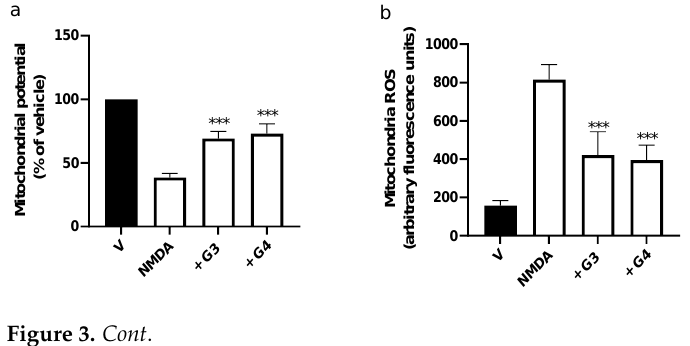
Figure 3. Effect of G3 and G4 phosphorous dendrimers on NMDA-induced changes in Ψm and ROS levels. Neurons were treated with vehicle (V), G3, or G4 phosphorous dendrimers (10 µM) for 1 h, and then NMDA (150 µM) was added. Neuronal ( a ) mitochondria potential, ( b ) mitochondrial ROS, and ( c ) total cellular ROS were determined as indicated in the Materials and Methods section. The data are expressed as the mean + the s.e.m. of 30 to 40 neurons obtained from four independent experiments. *** p < 0.001 as compared to NMDA-treated cells in the absence of dendrimers. 2.4. Phosphorous Dendrimers Inhibit NMDA-Induced Intrinsic Apoptotic Pathway Activation Loss of Ψm has been related to caspase activation and induction of the intrinsic apoptotic pathway [33]. Thus, we studied the effect of phosphorous dendrimers on NMDA-mediated activation of caspases 9 and 3. Treatment of mouse cortical neurons with NMDA resulted in an early activation of caspase 9, coinciding with the loss of mitochondrial membrane potential (Figure S5a). Caspase 9 activation was followed by caspase 3 activation, which reached maximal activity at 3 h (Figure S5b). Lengths of time for maximal NMDA-induced caspase 3 and 9 activation were selected for the next experiments. Both phosphorous dendrimer generations reduced NMDA-induced caspase 9 (Figure 4a) and 3 (Figure 4b) enzymatic activity in a dose-dependent manner. This suggests that, at least in part, the neuroprotective effect of these phosphorous dendrimers was related to an inhibition of the intrinsic apoptotic pathway.